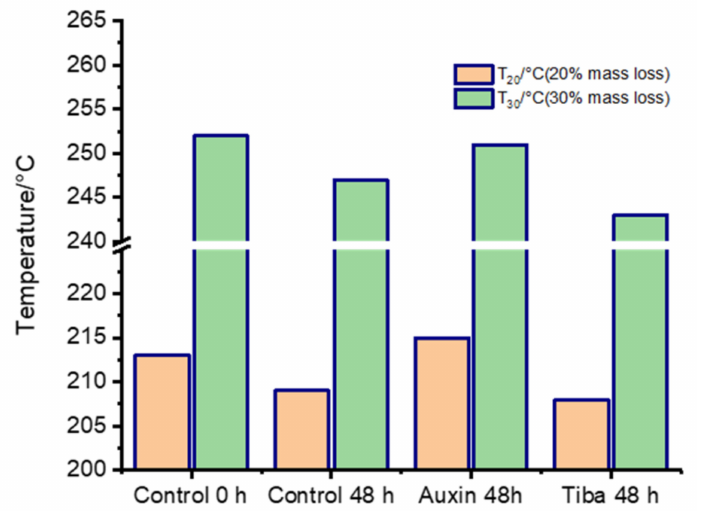
Figure 4. Temperature degradation of different samples 48 h post-treatment compared to control 0 h post-treatment. The graph shows the temperatures corresponding to sample loss of 20% of 30%